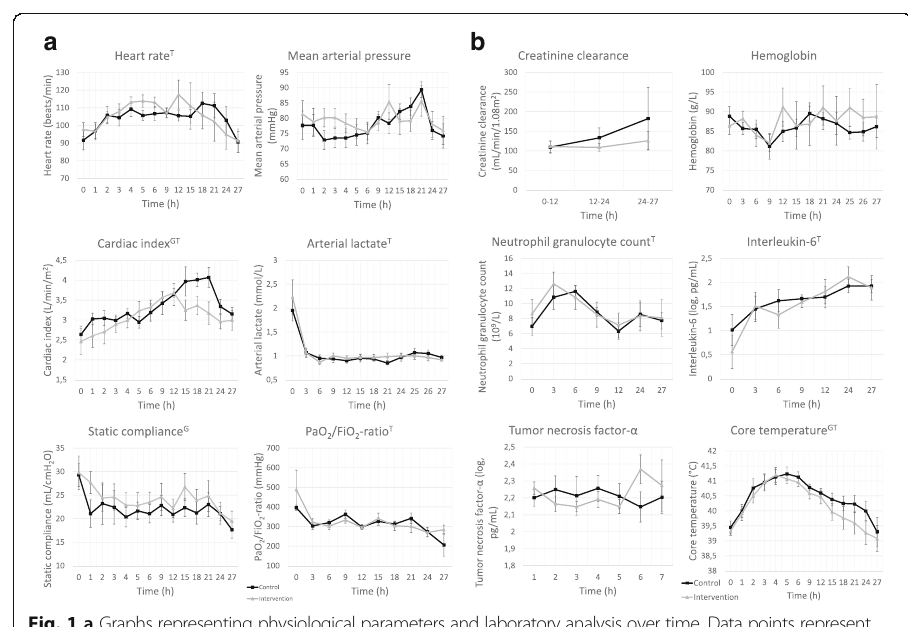
Fig. 1 a Graphs representing physiological parameters and laboratory analysis over time. Data points represent mean and error bars represent SEM. Black line represents the control group and gray line represents the intervention group. G, significant group difference; T, significant difference over time. No parameters had a significant group-time interaction. b Graphs representing physiological parameters and laboratory analysis over time. Data points represent mean and error bars represent SEM. Black line represents the control group and gray line represents the intervention group. G, significant group difference; T, significant difference over time.